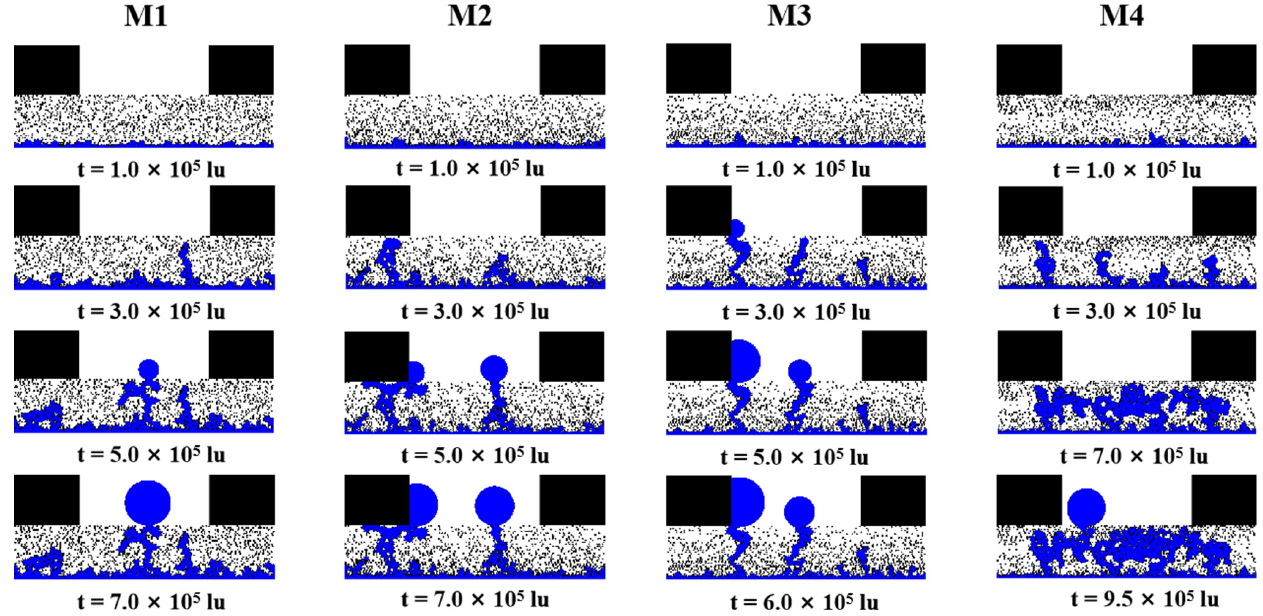
Figure 3. The liquid water distribution for M1, M2, M3, and M4 at different simulation times.